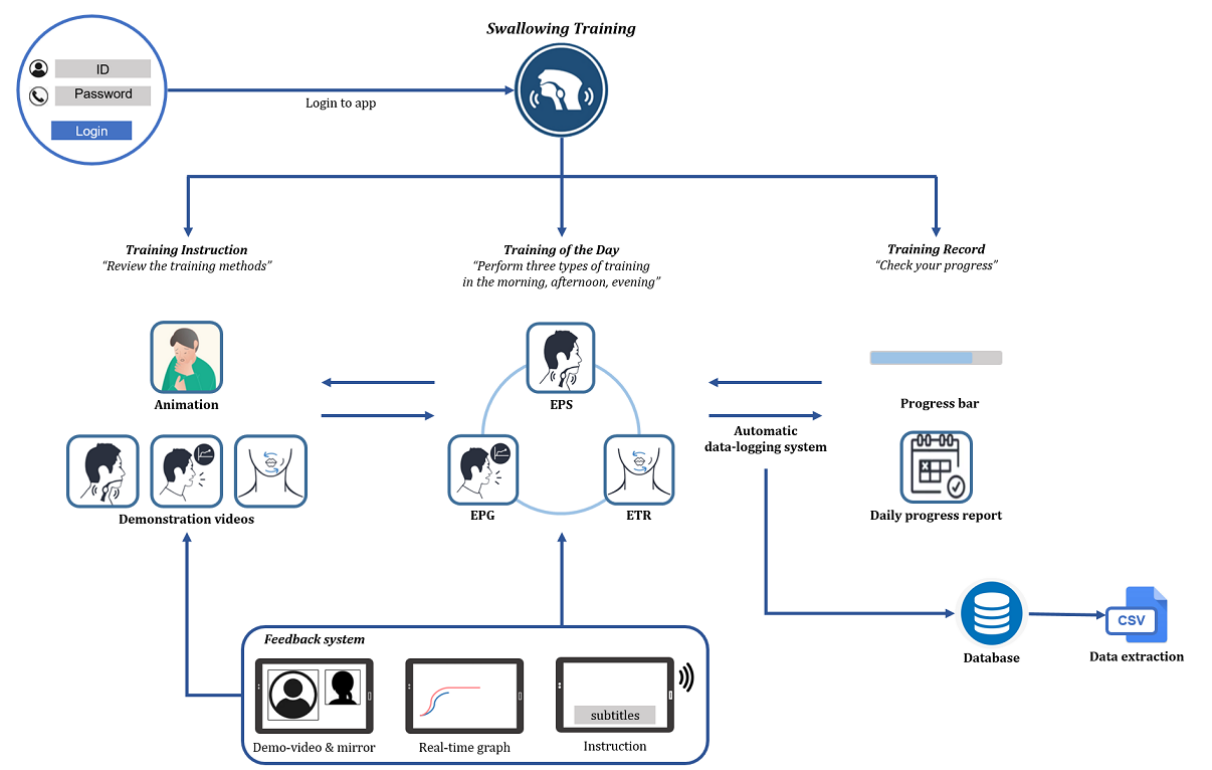
Figure 1. Overview of the 365 Healthy Swallowing Coach app. EPG: effortful pitch glide; EPS: effortful prolonged swallow; ETR: effortful tongue